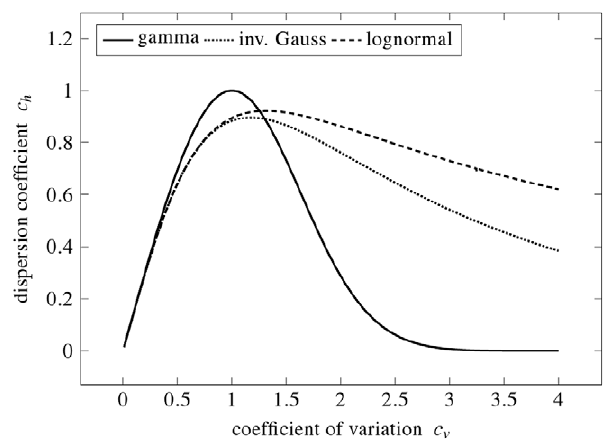
Figure 3. Entropy-based dispersion coefficient, c h , in depen- dence on the coefficient of variation, c v . Three interspike interval models: gamma, inverse Gaussian and lognormal distribution, are employed. Both c v and c h describe ‘‘spread’’ of the interspike intervals, but from different points of view. Coefficient of variation, c v , quantifies how off-centered is the mass of the probability density function, whereas c h indicates how evenly is the mass distributed over all possible values. For all the shown distributions holds c h ~ 0 as c v ? 0 or